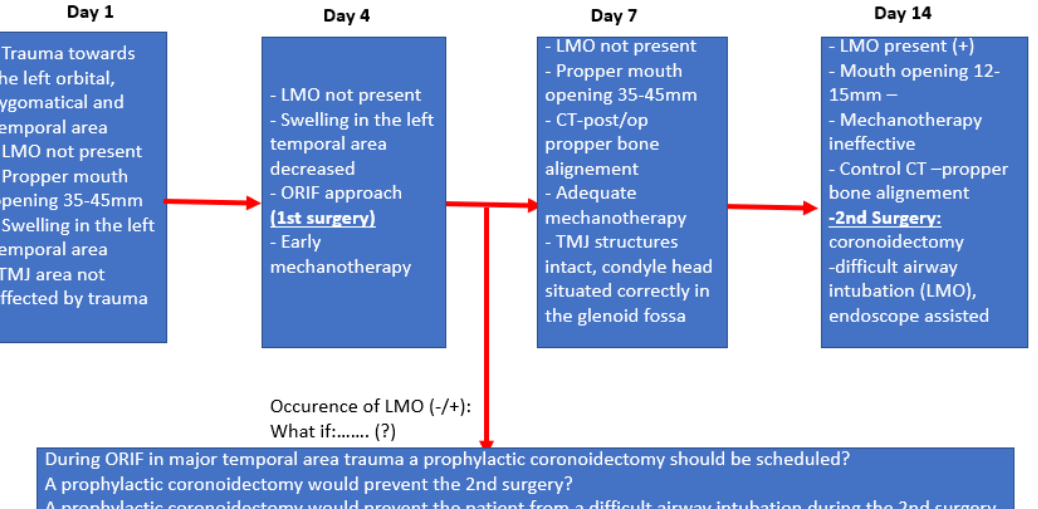
Figure 2. The diagram of events leading to a second surgery, including a coronoidectomy. This situation could be easily avoided if a prophylactic coronoidectomy was used during stable bone osteosynthesis; however, the indications for such are greatly case-related. Abbreviations: ORIF — open reduction and internal fixation (stable bone osteosynthesis); LMO — limited mouth opening; MM — millimeters (1 mm = 10 cm); (+) present; ( − ) absent.